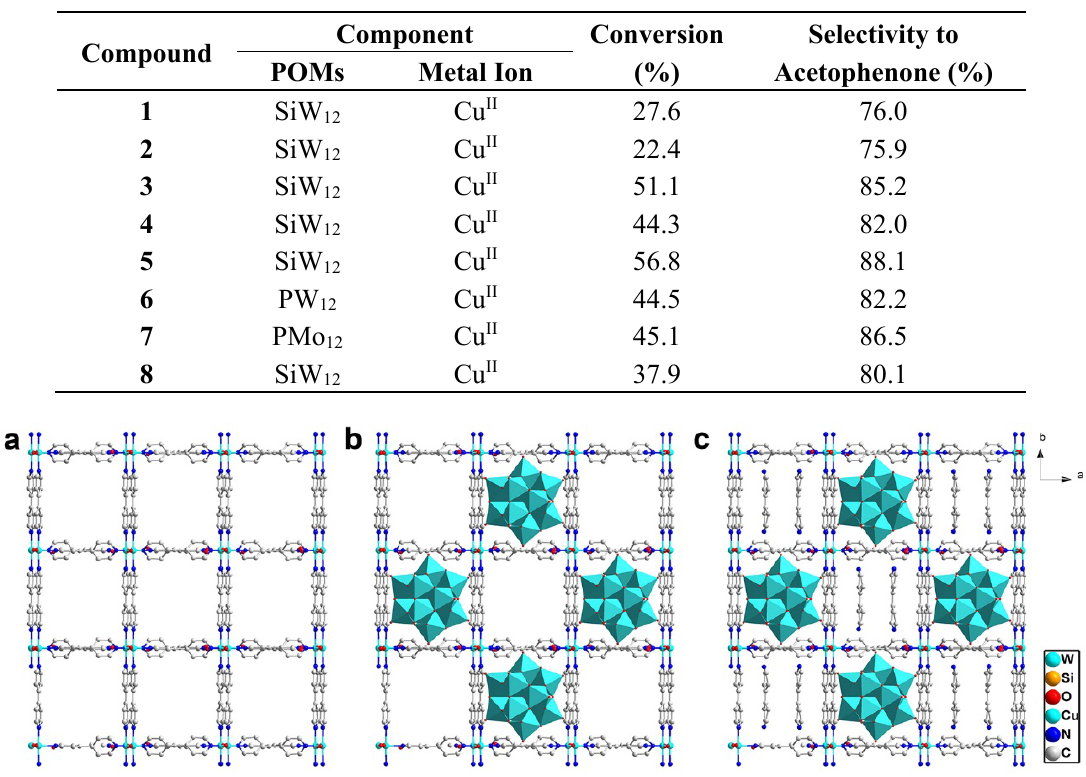
Table 1. Catalytic results for oxidation of ethylbenzene over compounds 1 – 8 .